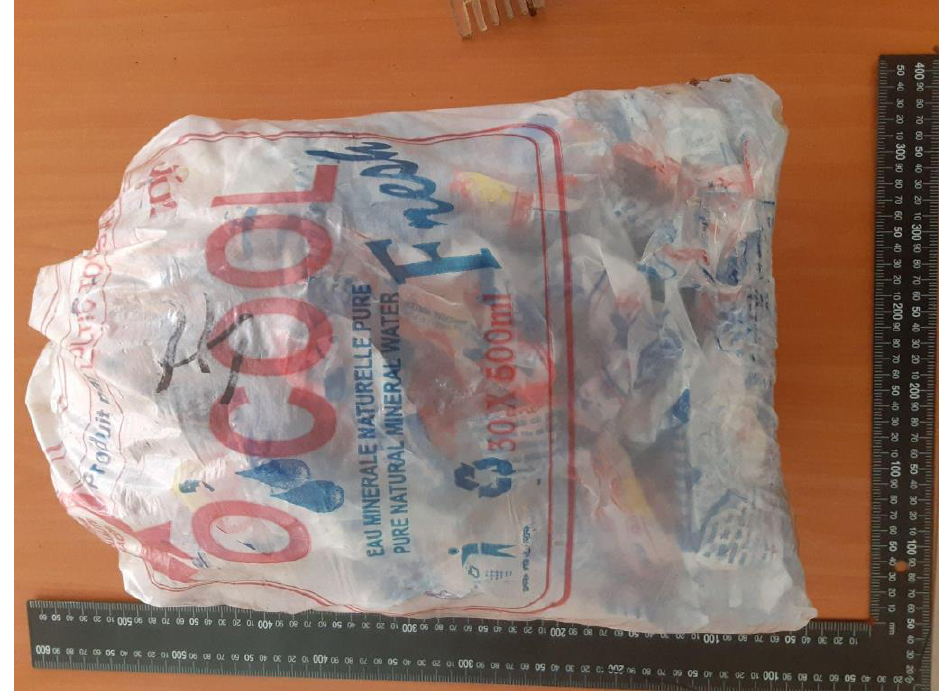
Figure 2. An example of LDPE plastic water sachet collected in Lomé, Togo, and